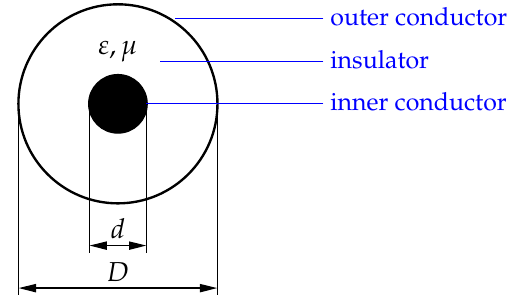
Figure 3. Cross-section of a coaxial cable.